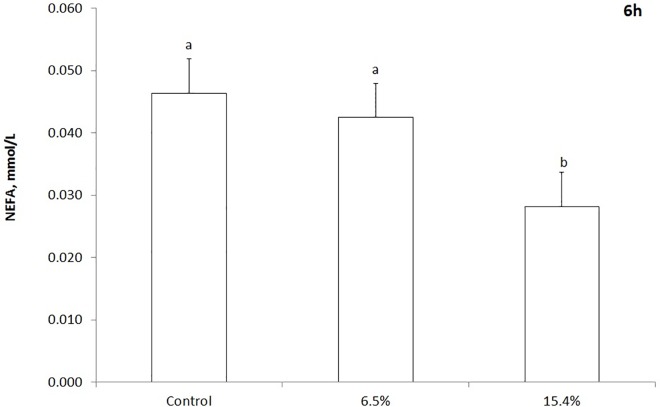
Concentration of NEFA in blood of dairy cows fed different concentrations of T. diversifolia 6 h after feeding.